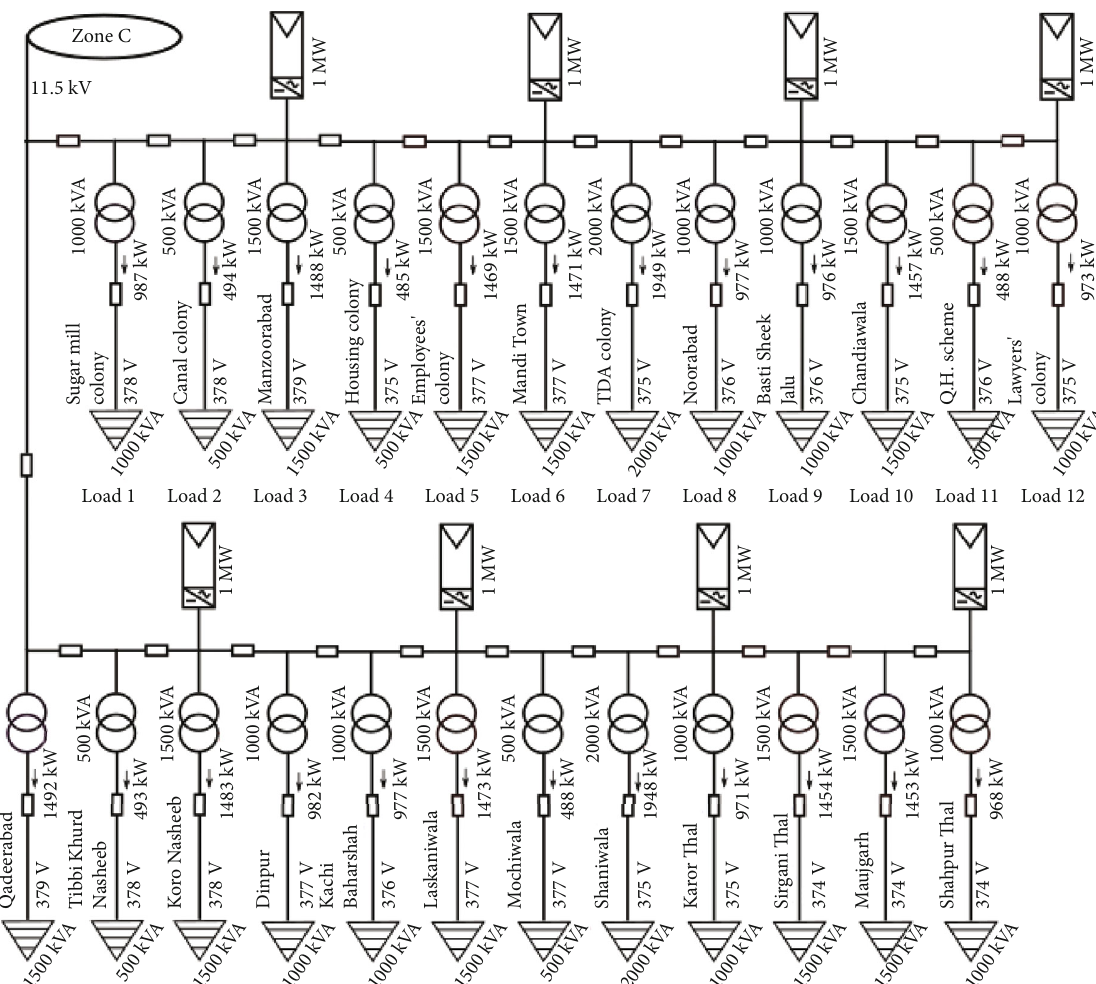
Figure 12: Implementation of zone A of the new system on